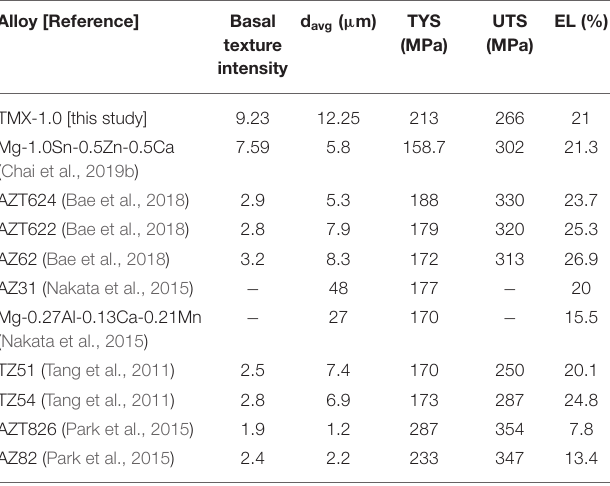
TABLE 1 | Summary of average grain size (d avg ), basal texture intensity and tensile properties in different Mg alloy systems in literature and this study. Alloy